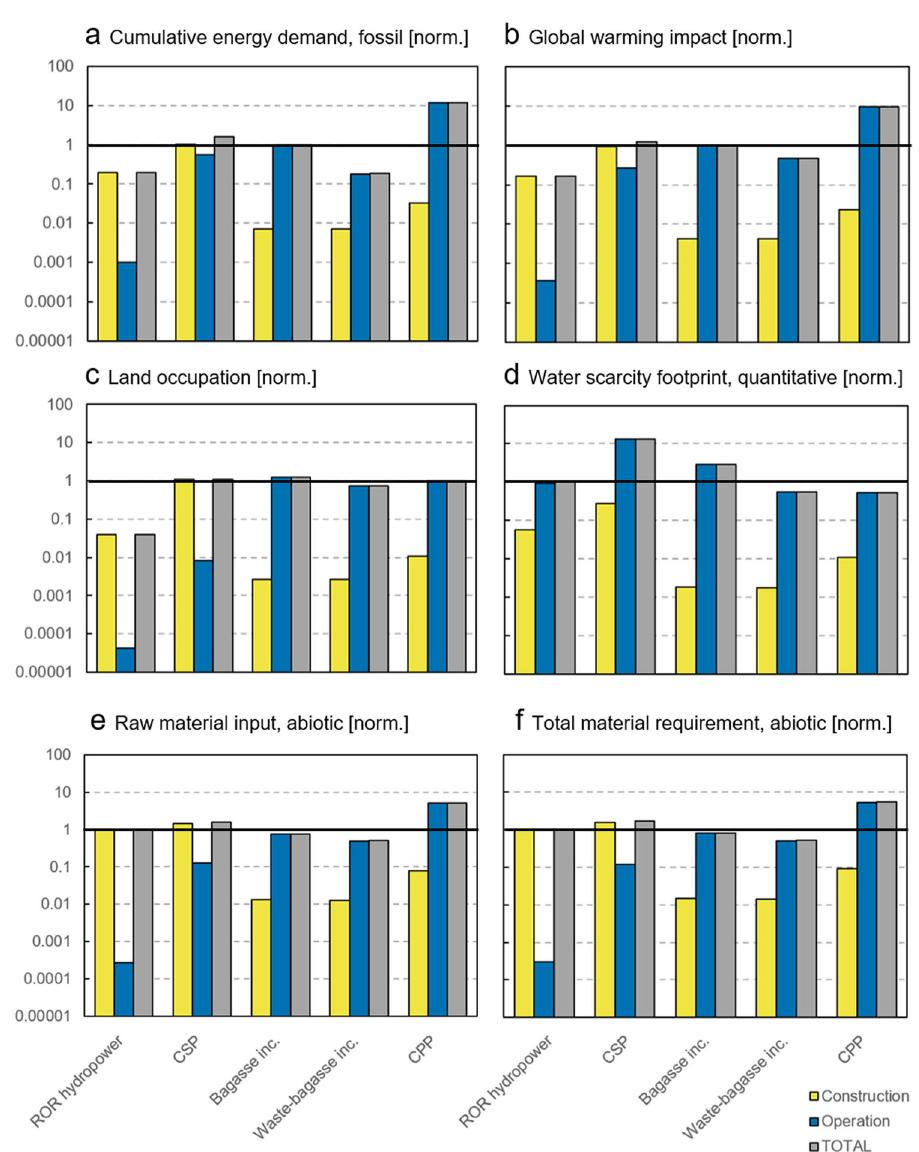
Fig. 2 Environmental pressures of electricity generation systems. Results are presented per environmental pressure a – f for the construction (yellow bars) and operation (blue bars) phase on a logarithmic scale per 1 kWh produced electricity, respectively. For each environmental pressure, LCIA results for operation, construction and total have been normalised by the median total result of all case studies. This approach ensures that the ratios between operation and construction are maintained and that the grey sum bar corresponds to the sum of the yellow and blue bar, respectively. Since a normalised value of 1 represents environmental pressures identical to the median, the corresponding grid line is highlighted in bold. ROR run-of-river, CSP concentrated solar power plant, Bagasse inc. Bagasse incineration, CPP coal- fi red power